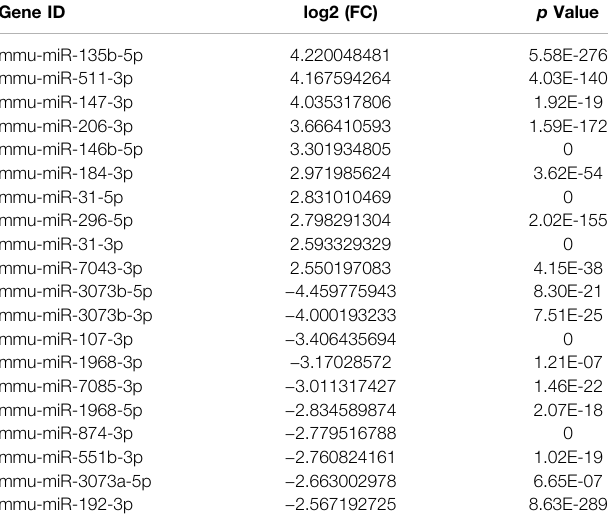
TABLE 3 | The top 10 most upregulated and downregulated